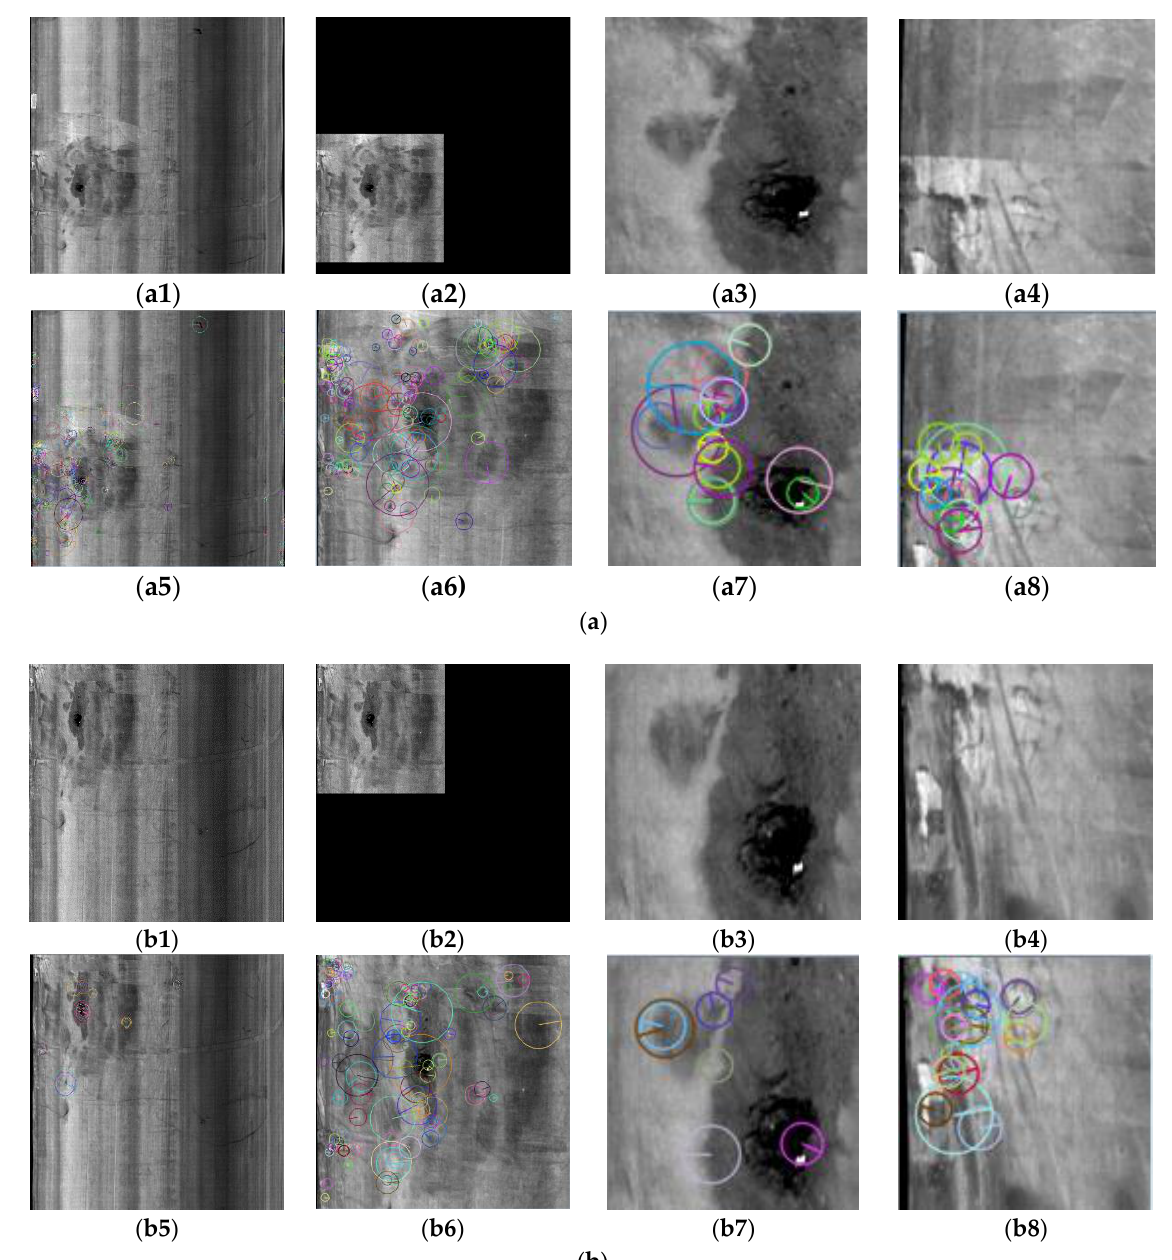
Figure 12. Experimental platform.